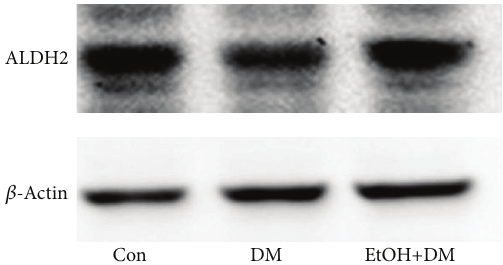
Figure 5: ALDH2 protein expression by western